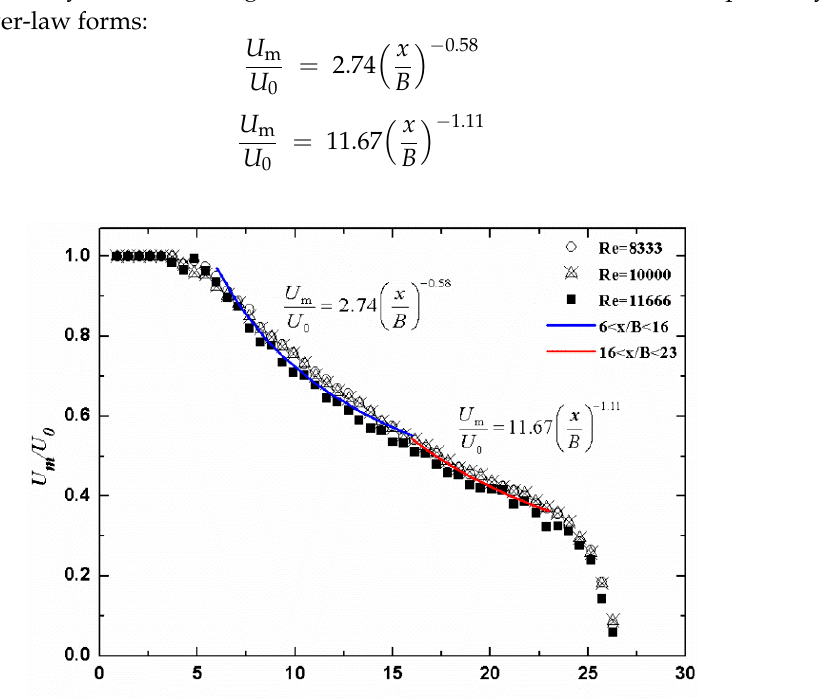
Figure 8. Decay of local maximum velocity U m .